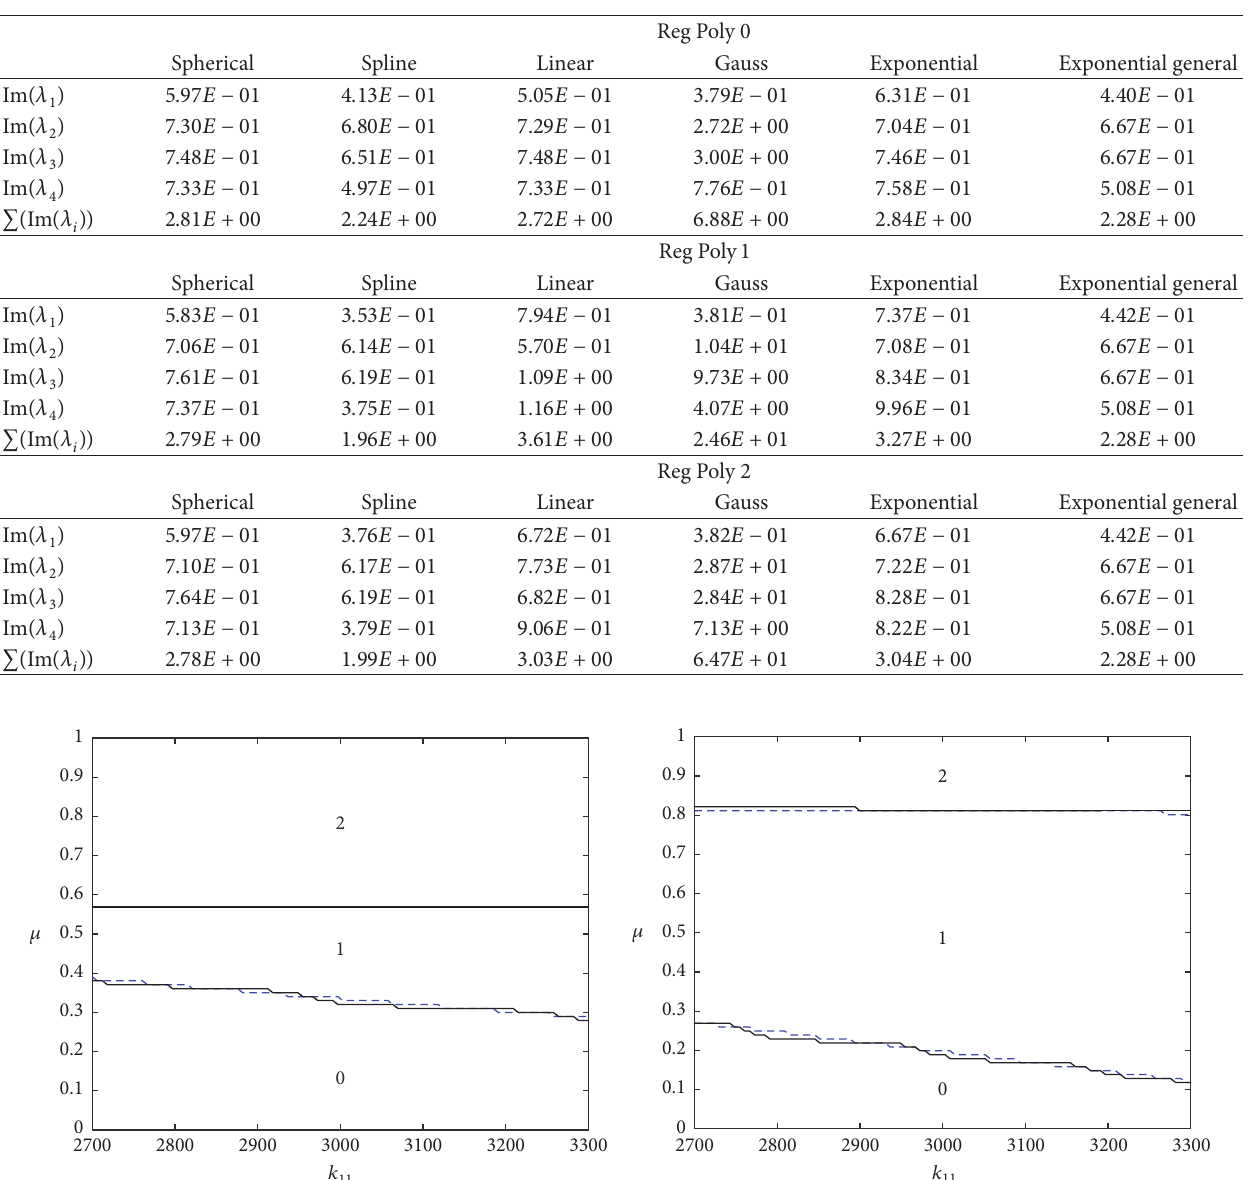
Table 10: Configuration 2: maximum absolute error on imaginary parts of eigenvalues for different regression and correlation kriging functions.